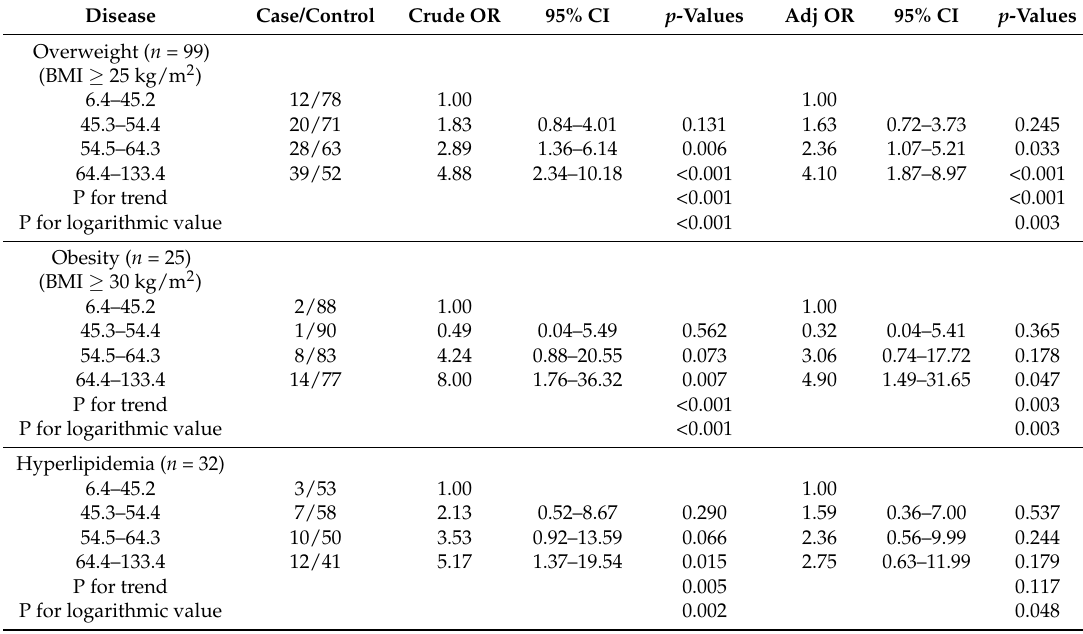
Table 6. Association of zonulin levels and risk conditions and disease